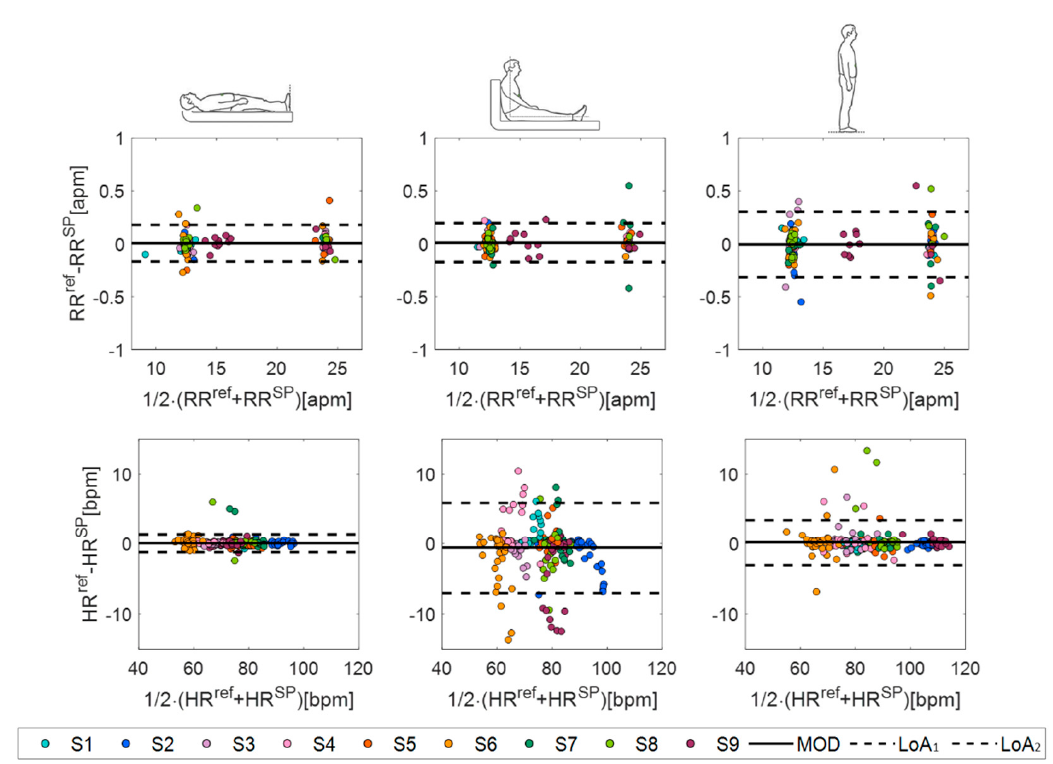
Figure 13. Bland–Altman plots: MOD (black line) and LOAs (black dotted lines) related to RR and HR in supine, sitting, and standing positions.